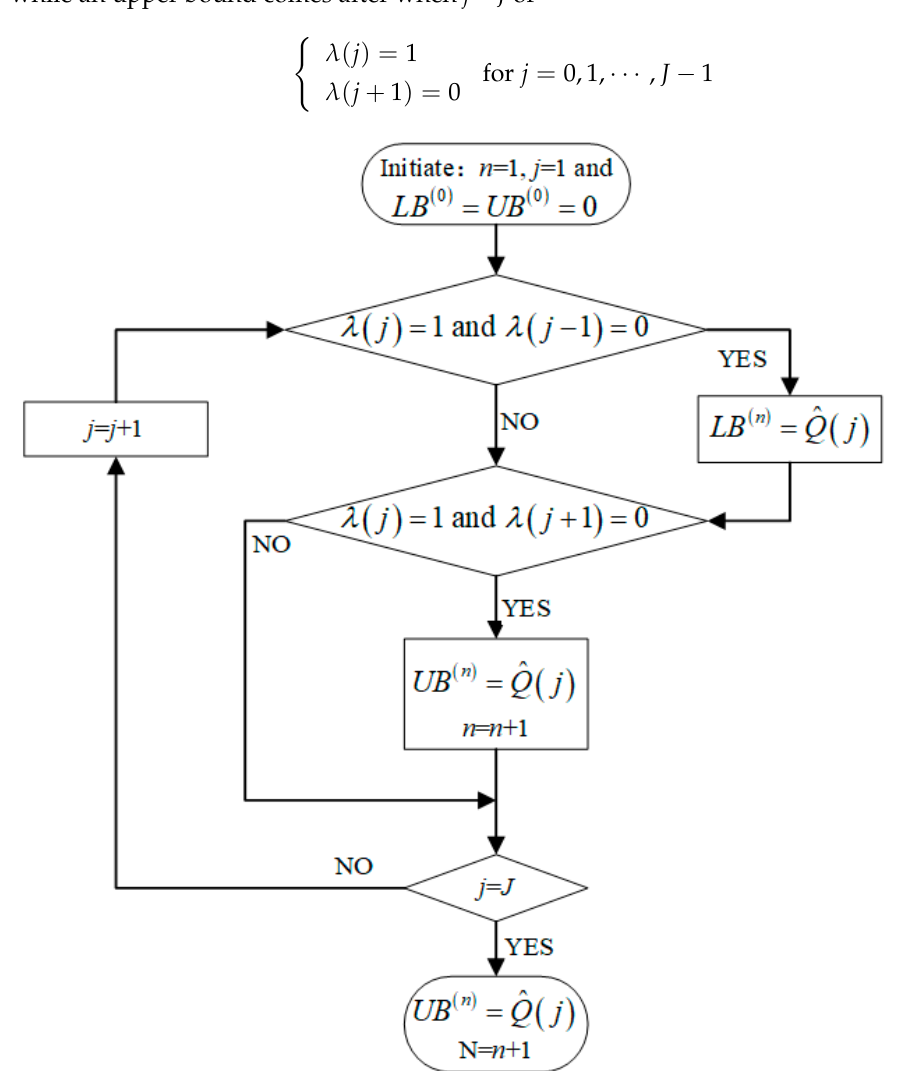
Figure 1. Procedure to determine the plant ‐ based operating zones.